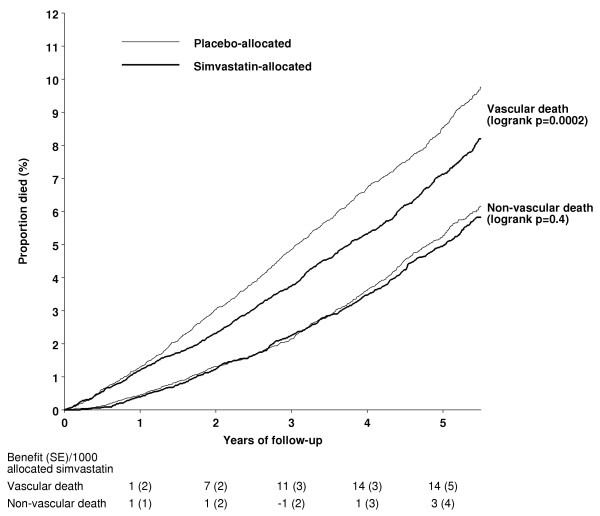
Life-table plot of effects of simvastatin allocation on vascular and non-vascular death. See figure 2 for numbers of participants dying during follow-up.